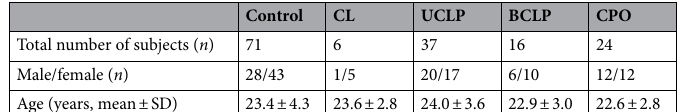
Table 4. Distribution of the sample according to sex and age. S.D. Standard